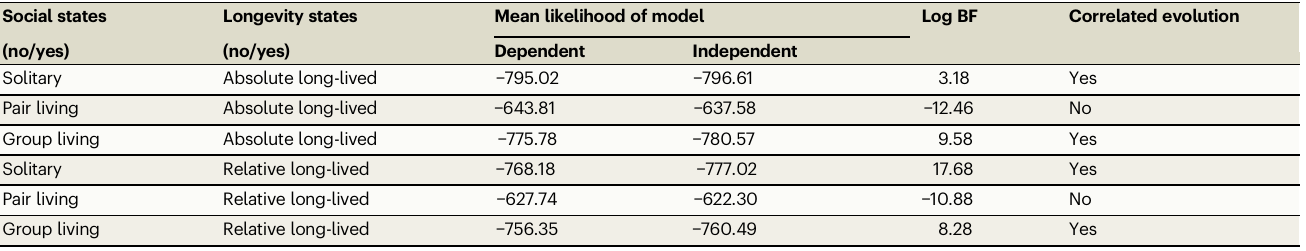
Table 2 | Likelihoods of dependent and independent models estimated for the correlated evolution of social organization and longevity Social states